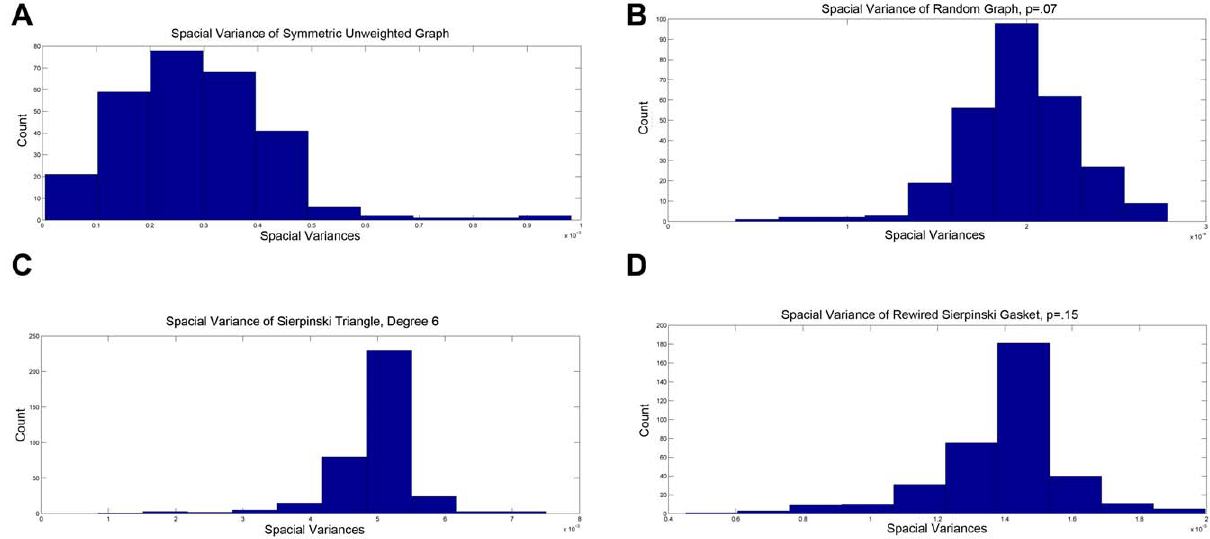
Figure 4. Spacial Variance (a) C. elegans neural network (b) Random Graph ( n ~ 279, p ~ 0 : 07 ) (c) Sierpinski Gasket, Level 5 (d) Sierpinski Gasket Rewiring ( p ~ 0 : 15 ).